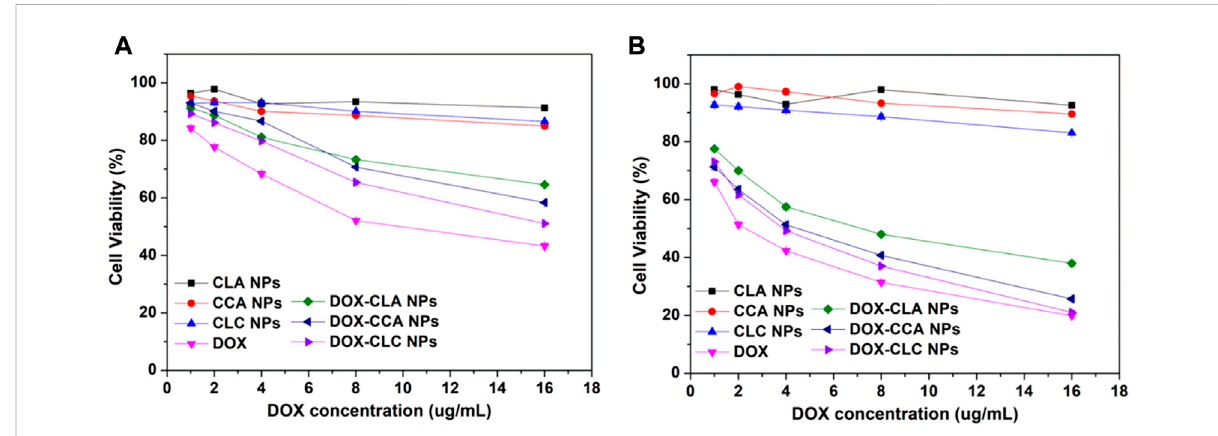
FIGURE 6 Cytotoxicity of each sample after co-cultured with H22 cells (A) and HepG2 cells (B) for 48